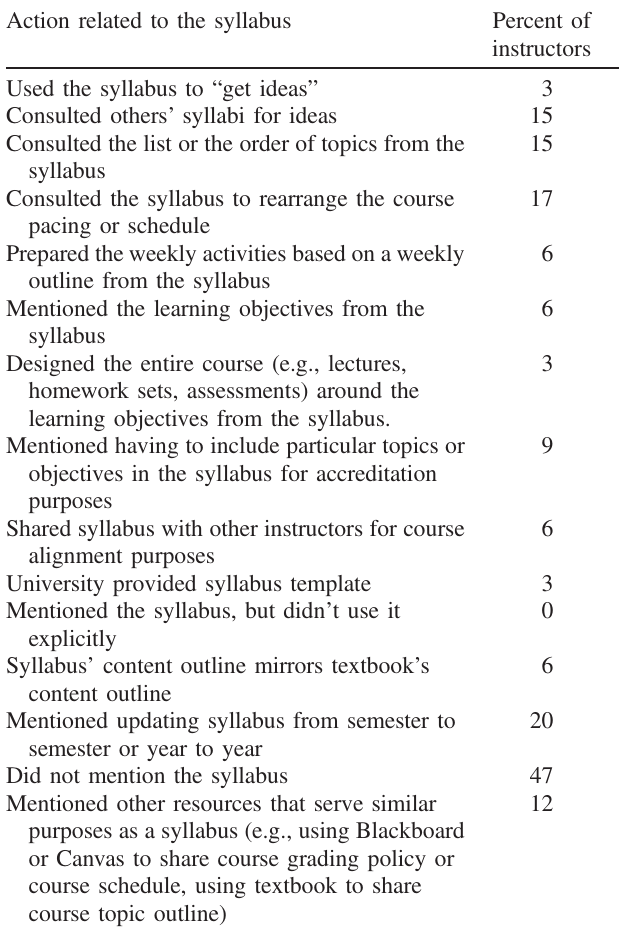
TABLE VII. How the interviewees used the syllabi or talked about it in their course preparation process ( N ¼ 35 ). Some interviewees performed more than one of the actions listed. Note this list reflects what faculty shared with us during interviews, but may not be inclusive of all their practices.